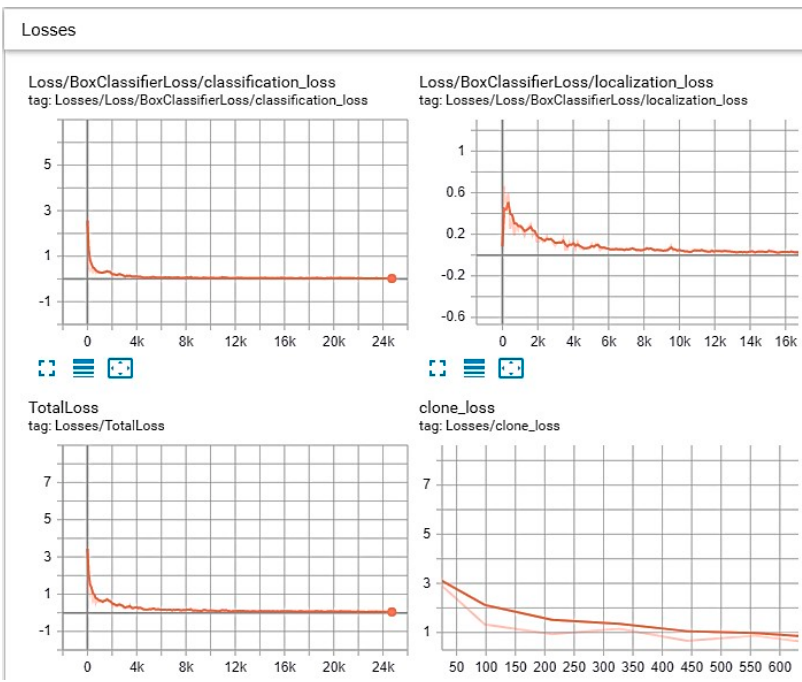
Figure 12. The use of TensorBoard to monitor the loss and check on accuracies within the models during evaluation. during evaluation.